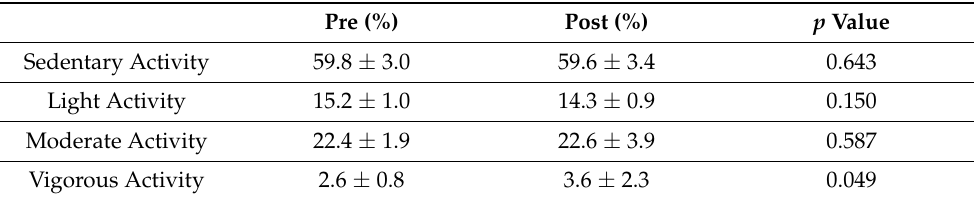
Table 1. Physical activity percentage breakdown according to intensity pre- and post-intervention using a wrist-worn accelerometer ( N =